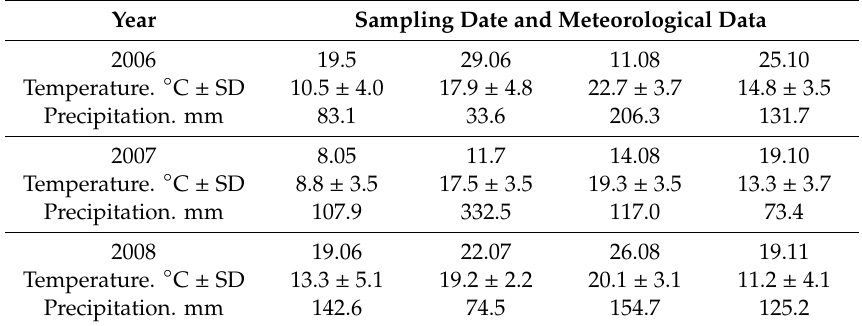
Figure 1. Daily mean air temperature and precipitation at the Experimental Station during the study. Table 1. The calendar date of soil sampling and basic meteorological data in the period preceding grazing in respective